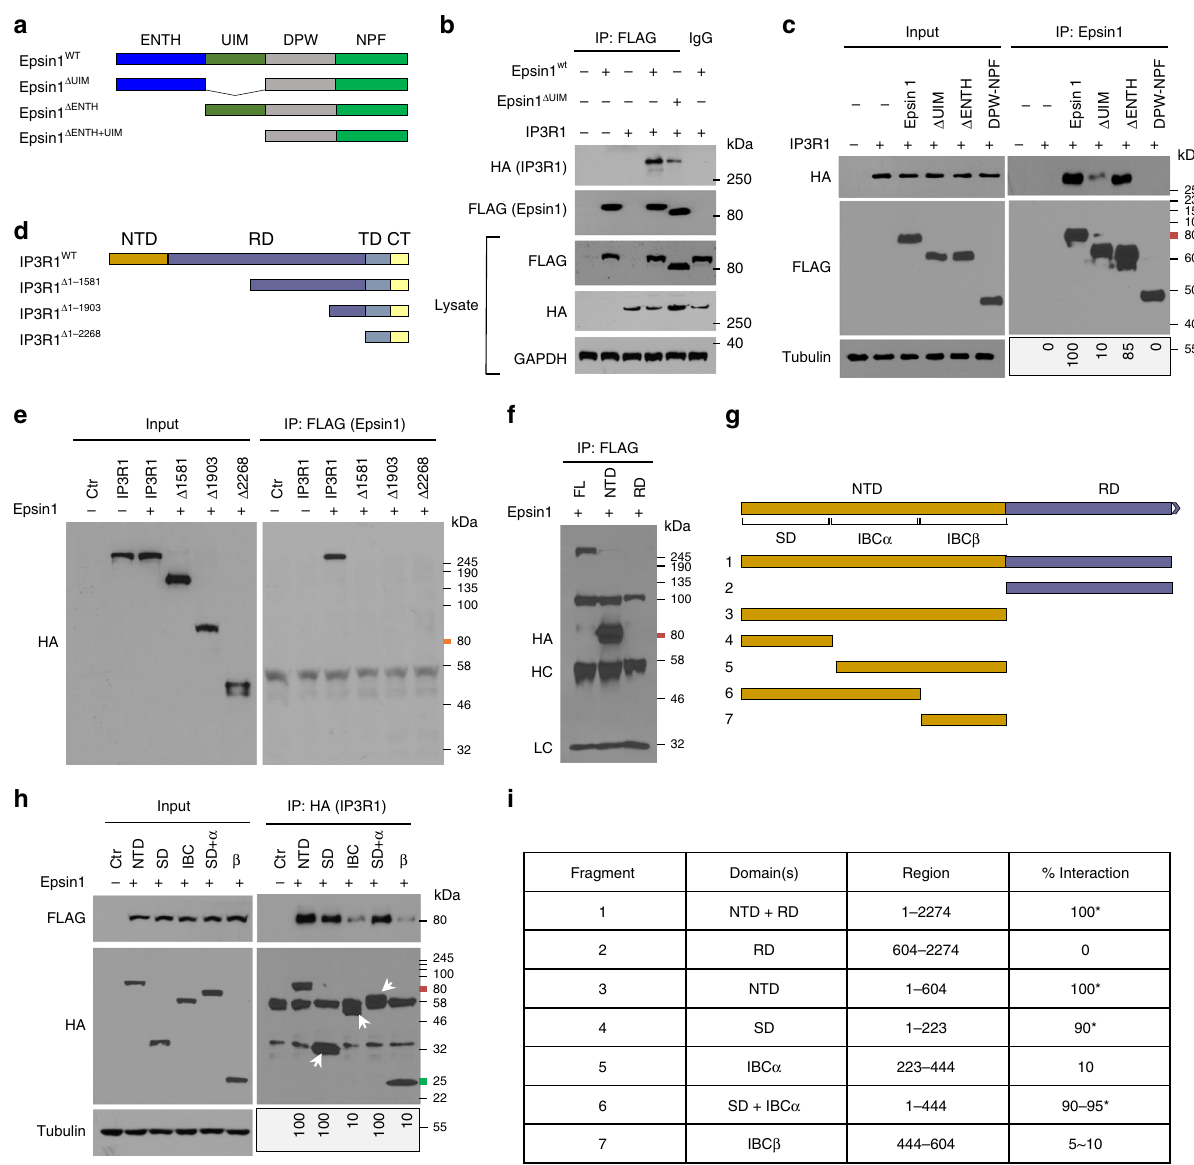
Fig. 2 IP3R1 SD and epsin 1 UIM domains interact under atherogenic conditions. a to c Full length and domain-deletion constructs of FLAG-epsin 1 in the pcDNA3 vector were transfected into HEK 293T (293tsA1609neo) cells for 24 h, followed by IP and western blot analysis using antibodies against HA (IP3R1) or FLAG (epsin 1) tags, as well as speci fi c proteins ( n = 5). d – f Full length and deletion constructs of HA-IP3R1 were transfected into HEK 293T cells for 24 h, followed by IP and western blot analysis using antibodies against HA or FLAG tags and speci fi c proteins ( n = 5). g to i Fine mapping of the N-terminus of IP3R1 to determine the region that interacts with epsin 1. Interaction results are presented as a 0 – 100 scale mapping domain(s) that bind (s) epsin 1 upon co-expression in 293T cells ( n = 6, asterisk P < 0.001, compared to the fragments deleted SD). Transfected HEK 293T cells were all treated with 100 μ g/mL oxLDL for 30 min. NTD N-terminal domain, RD regulatory domain, TMD transmembrane domain, CTT C-terminal cytoplasmic tail, SD suppressor domain, IBC IP3 binding core composed of α and β Epsin 1 modulates receptor degradation through binding to changes in IP3R1 mRNA levels, implying IP3R1 was regulated by ubiquitinated IP3R1 . To establish the consequences of the epsins at the protein level, which is consistent with the corre- sponding GO analyses (Supplementary Fig. 6d and, as well as interaction between epsin 1 and IP3R1, we isolated MAECs from Supplementary Data fi le 2). In support of this interpretation, control (ApoE − / − ) and mutant mice (EC-iDKO/ApoE − / − ) and treated these cells with atherogenic cholesterol to determine the acute oxLDL treatment (0, 50, 100, and 200 µg/mL) increased effect on speci fi c gene expression, as well as ubiquitination and ubiquitination of IP3R1 in the presence of MG132, which inhibits proteasomal degradation of IP3R1. Unlike acute (30 min) treat- degradation of ubiquitin-conjugated proteins and permits ments with 100 µg/mL oxLDL or 50 µM 7-KC (Fig. 1c – f), total their quantitation (Fig. 3c and Supplementary Fig. 6f). The cell lysates from control mouse endothelial cells subjected to 36 h increased ubiquitination of IP3R1 in response to long-term of stimulation showed signi fi cant increases in both epsin 1 and 2 atherogenic cholesterol results in proteasomal degradation and protein levels (Fig. 3a, b). MAECs from EC-iDKO/ApoE − / − loss of this calcium release channel from the ER membrane (iDKO) mice treated with cholesterol for 36 h did not exhibit (Fig. 1g, h).